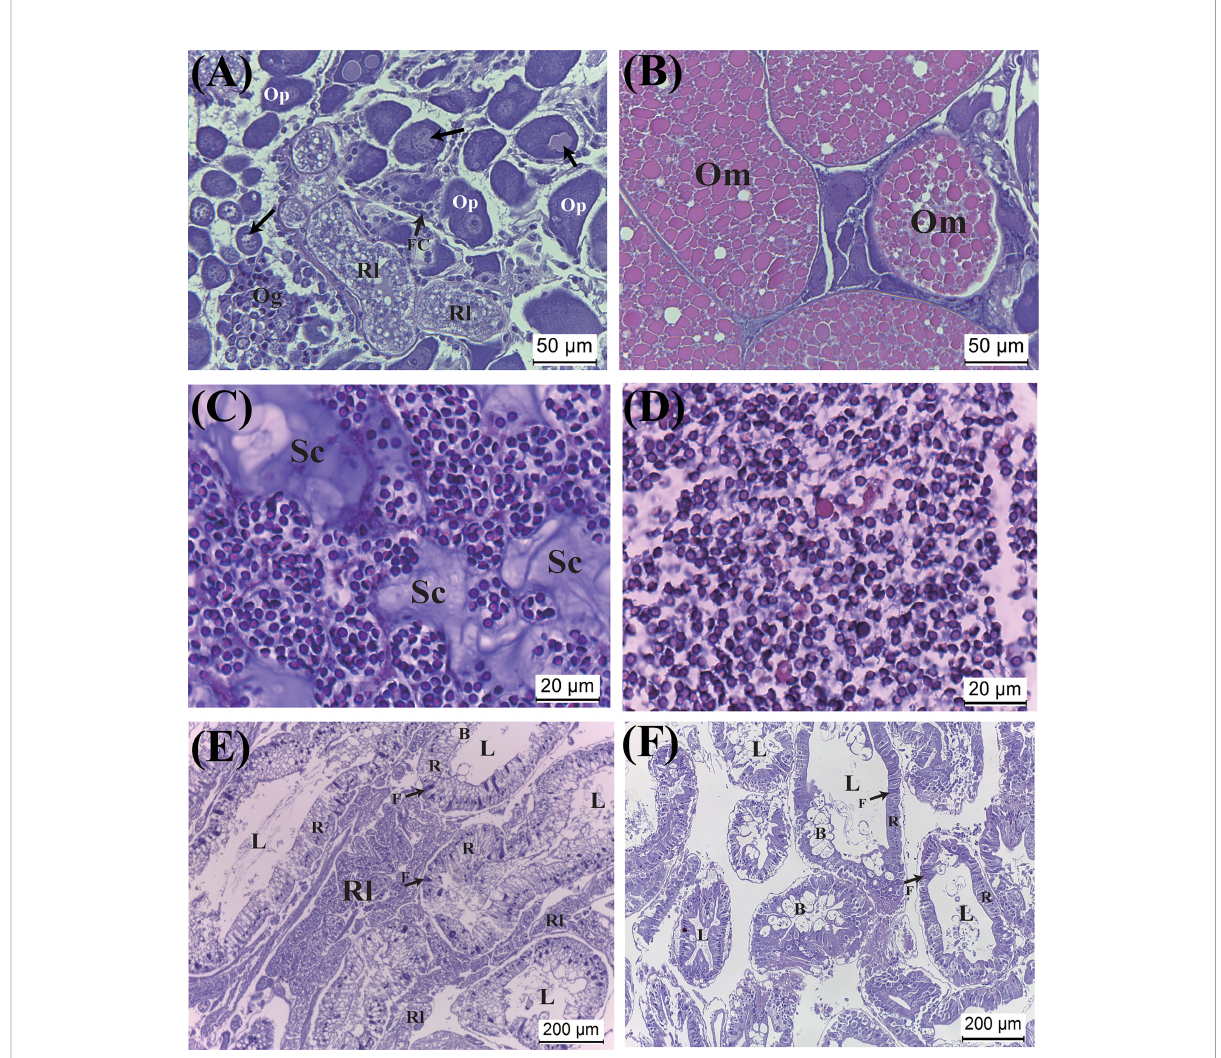
FIGURE 6 Effect of parasitism of Polyascus planus on the tissues of the host thukuhar shore-crab ( Metopograpsus thukuhar ). Tissues examined include the ovary (A, B) , testis (C, D) , and hepatopancreas (E, F) . Note that, for the parasitized hosts, the ovary and hepatopancreas (A, E) , but not the testis (C) , are heavily in fi ltrated by rootlets. The sections (A, C, E) shown for the parasitized hosts were from hosts bearing orange externa. Arrows in (A) point to degenerating oocyte. B, F, R: the B-, F-, R-cell of the epithelia. L, lumen; Om, mature oocyte; Og, oogonium; Op, pre-vitellogenic oocyte; Rl, rootlet; Sc,